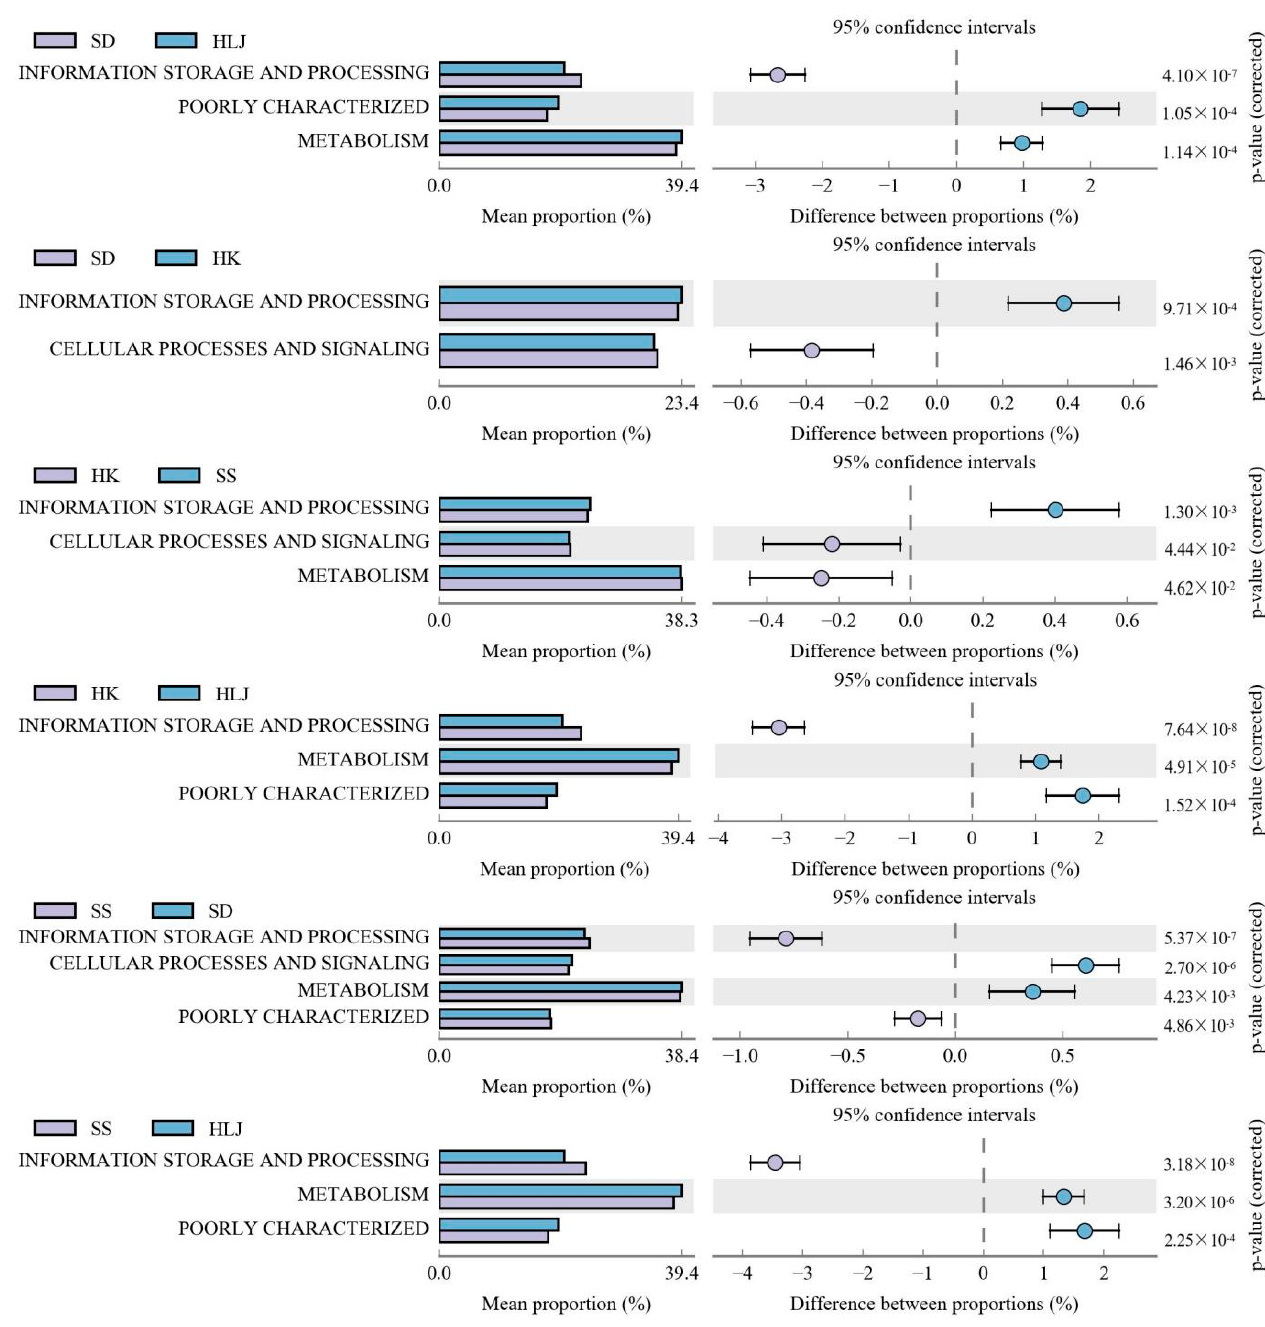
Figure 5. Fecal microbiome functions between comparisons with the COG functions analysis. 3.7. Some Microbial Phenotypes at the Organism Level Were Matched to the Geographical and